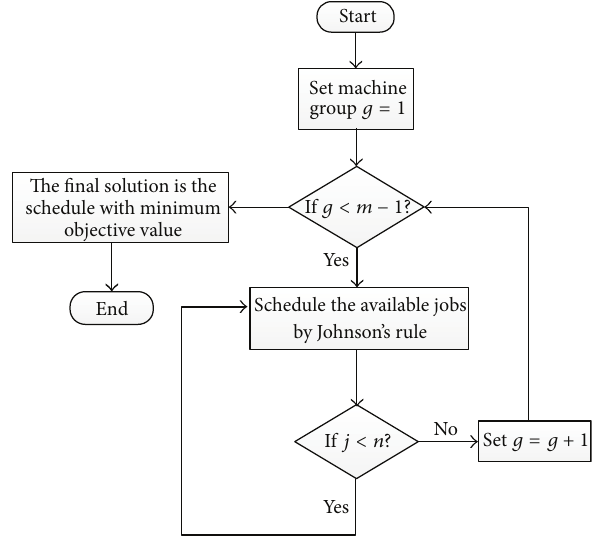
Figure 1: The flowchart of the MGS